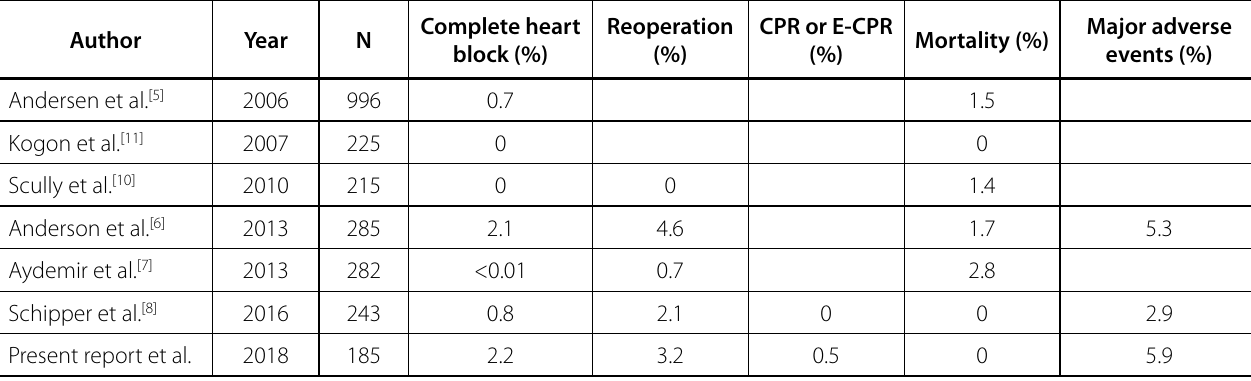
Table 6 . Results of VSD closure (studies after